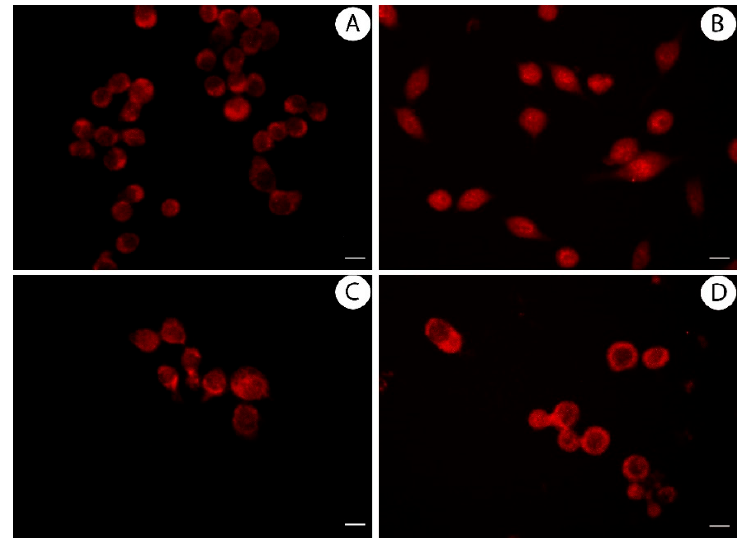
Figure 5. G. glabra L. leaf extract and licoflavanone inhibit NF-kB nuclear translocation. Immuno- fluorescent localization of NF-kB in RAW 264.7 cells treated for 1 h with DMSO ( A ), 1 μ g/mL LPS + DMSO ( B ), 1 μ g/mL LPS + 25 μ g/mL Extract C ( C ), 1 μ g/mL LPS + licoflavanone at IC 50 value ( D ). Scale bar: 25 μ m.